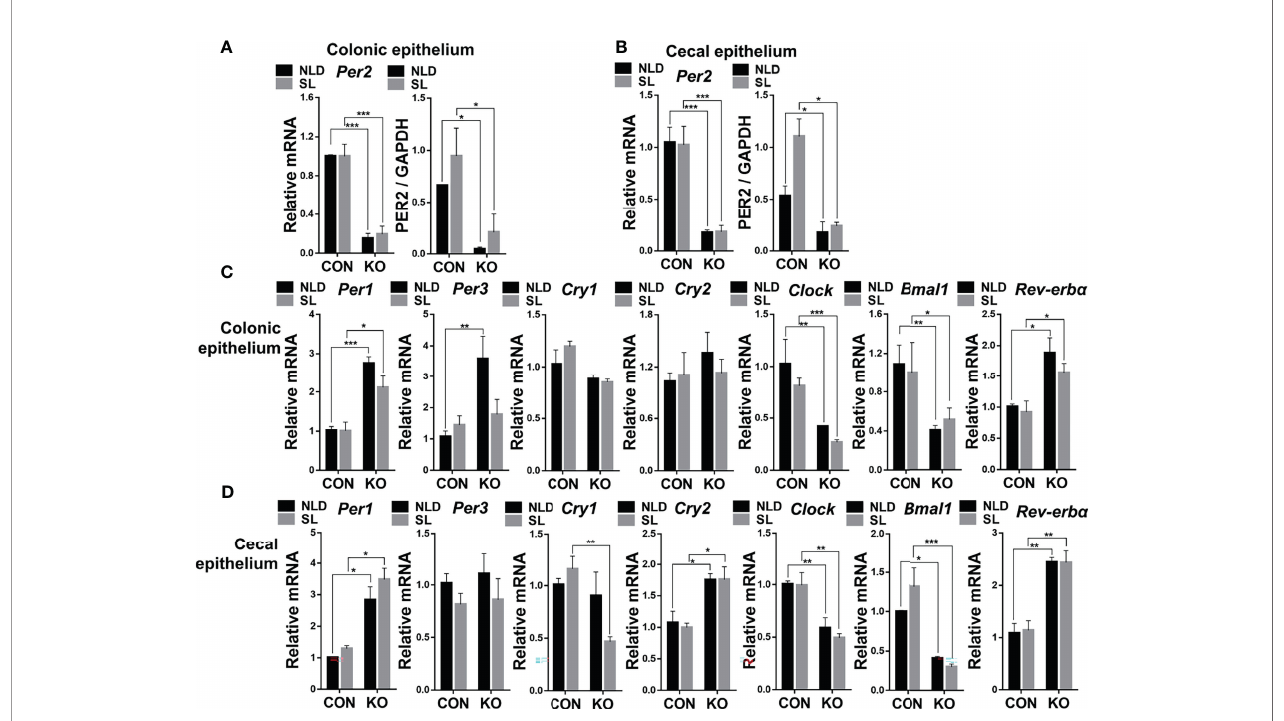
FIGURE 2 | Relative expression of colonic and cecal epithelial circadian rhythm genes and Per2 protein in KO and CON mice under NLD and SL. KO, Per2 gene knockout ( Period2 -/- ) mice; CON, wild-type ( Period2 +/+ ) mice; NLD, normal light – dark cycle treatment of 12 h of light and 12 h of darkness; SL, short-light treatment of 8 h of light and 16 h of darkness. Representative charts of the expression levels of Per2 gene and protein of colonic epithelium (A) and cecal epithelium (B) , Per1 gene, Per3 gene, Cry1 gene, Cry2 gene, Clock gene, Bmal1 gene, and Rev-erb a gene of colonic epithelium (C) and cecal epithelium (D) . Expressions of circadian genes and Per2 protein were determined in Per2 knockout and wild-type mice under NLD and SL by PCR and Western blot method. Statistical analyses were conducted using two-way ANOVA. * p < 0.05, signi fi cant difference; ** or *** p < 0.01 or p < 0.001, extremely signi fi cant difference. Results are presented as means ± SEM (n = 6 per